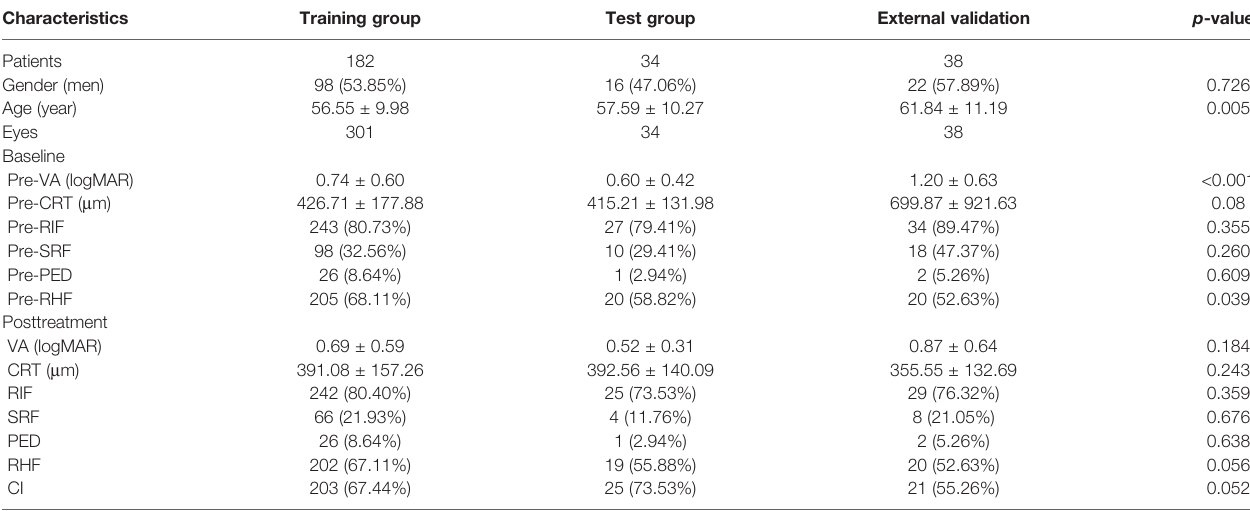
TABLE 1 | The characteristics of patients according to